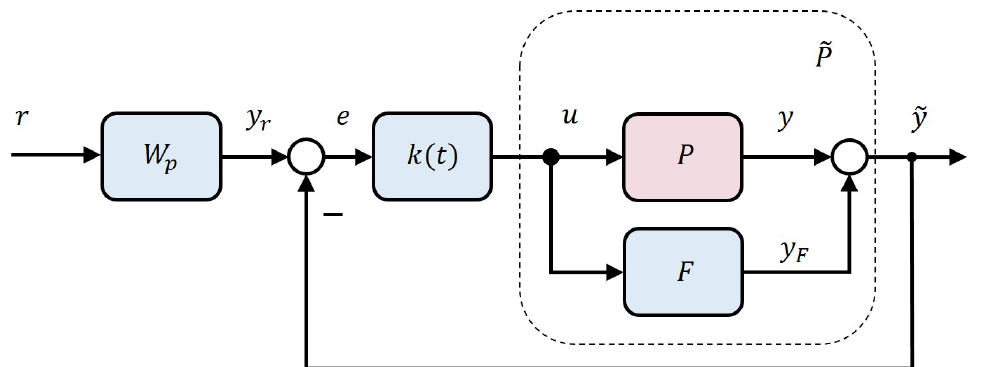
Figure 10. Overall control scheme: plant P , PFC F , precompensator W p and adaptive λ -tracking controller k ( t )